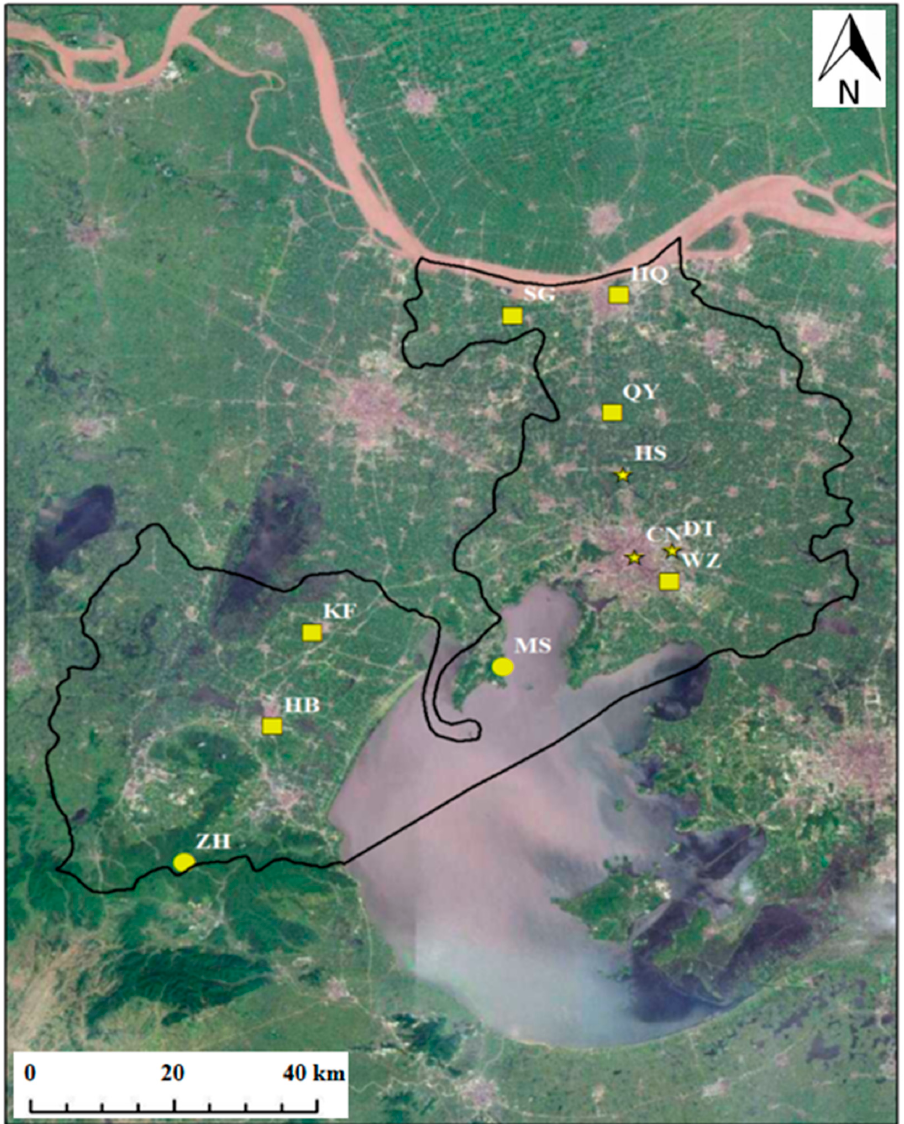
Figure 1. Sampling sites. In these 11 sites, urban sites (Dongting (DT), Chongning (CN), Huishan (HS)) are represented in yellow pentacles, industrial sites (Huanbaoju (HB), Kaifaqu (KF), Qingyang (QY), Shengang (SG), Hongqiao (HQ), Wangzhuang (WZ)) are represented in yellow squares, and clean sites (Mashan (MS), Zhuhai (ZH)) are represented in yellow circles. The black solid line marks the scope of Wuxi.